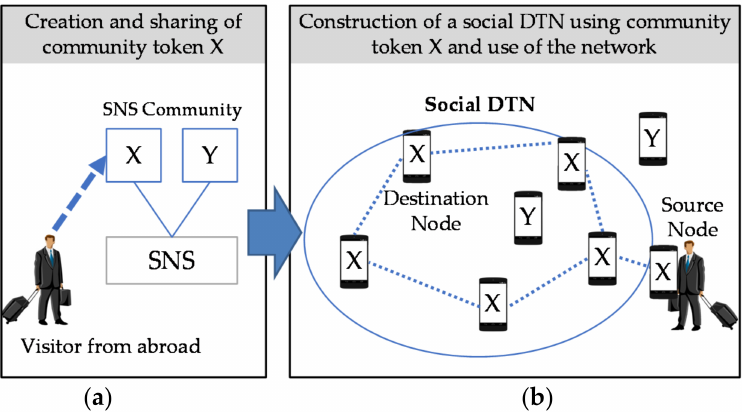
Figure 1. Example of using a social DTN (delay, disruption, disconnection tolerant networking). ( a ) The left figure shows an environment, such as an airport, where the user (e.g., a visitor from abroad) can access the Internet; ( b ) The right figure shows an environment, such as on the street, where the user cannot access the